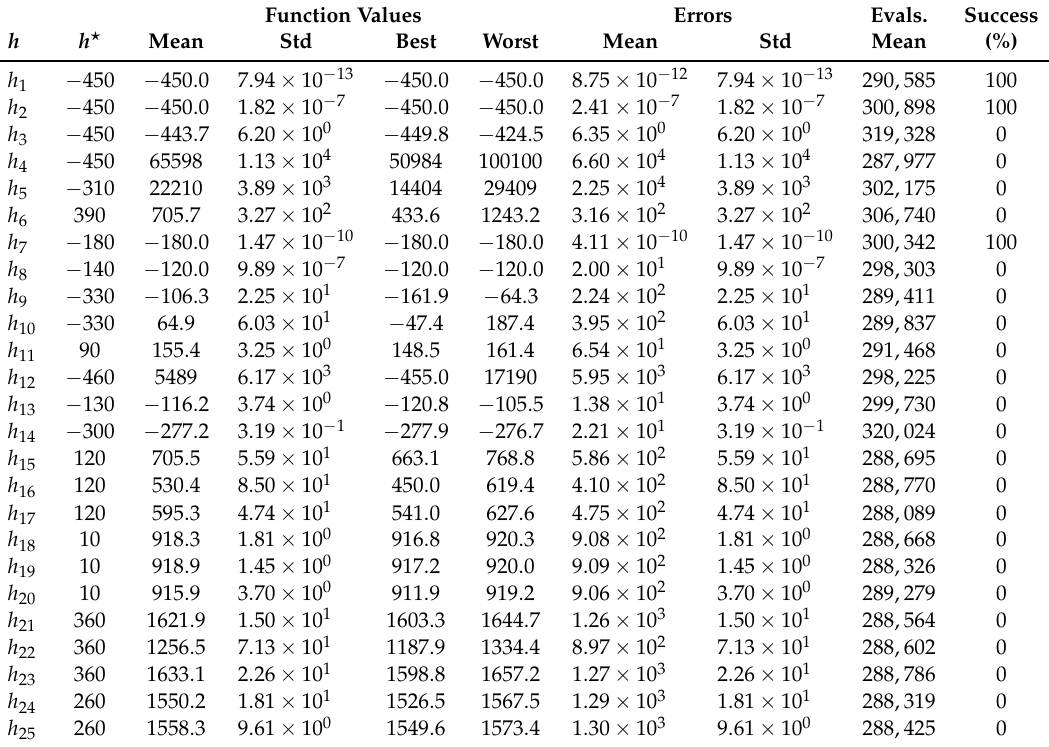
Table 9. The QCGA results of hard functions h 1 – h 25 with dimension n = 50. Function Values Errors Evals.